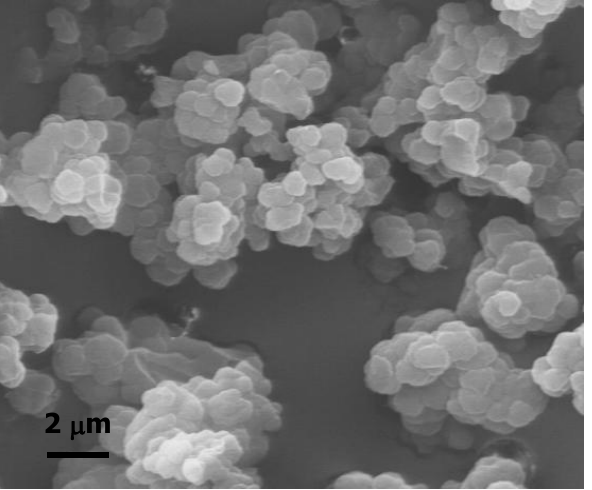
Figure 2. Scanning electron micrograph of the polymer obtained by precipitation